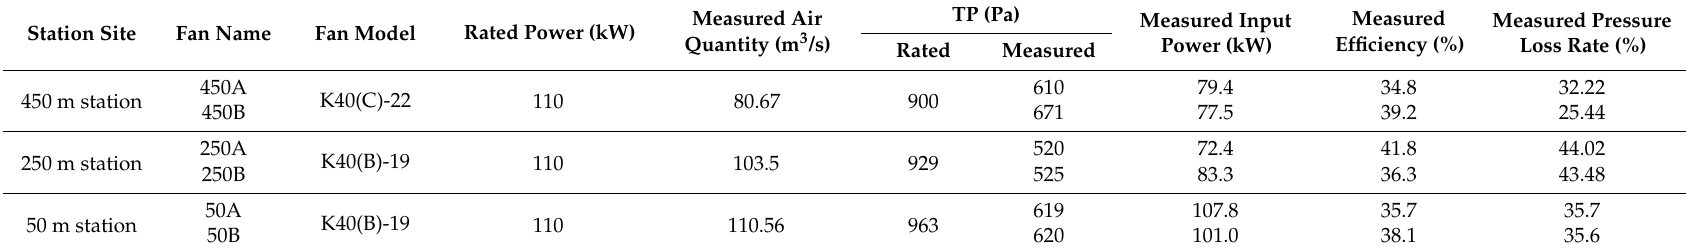
Table 1. Investigation and measurement of PFS in Gaofeng underground mine